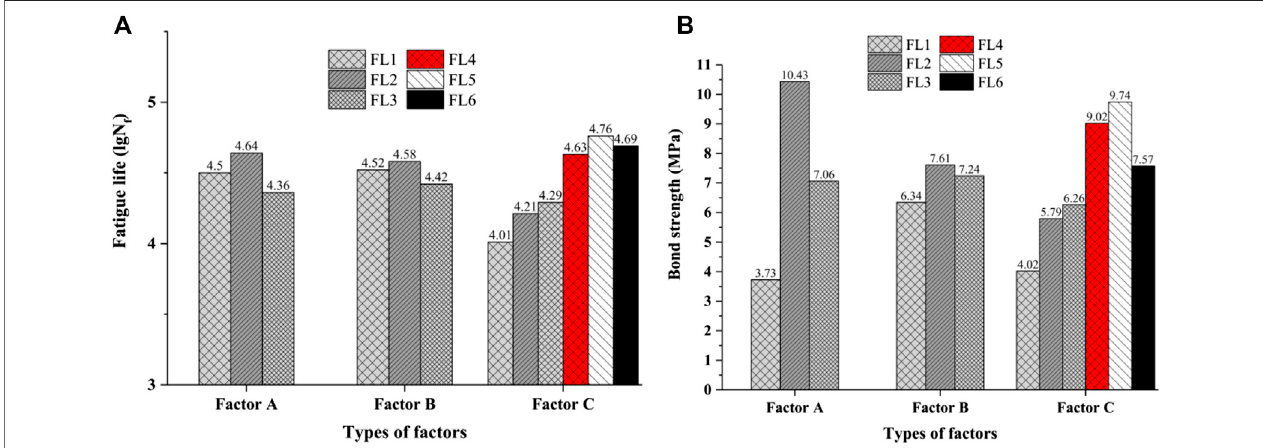
FIGURE 5 | Analysis test results for different factor levels: average value of (A) fatigue life for different factors and levels; (B) bond strength for different factors and levels.